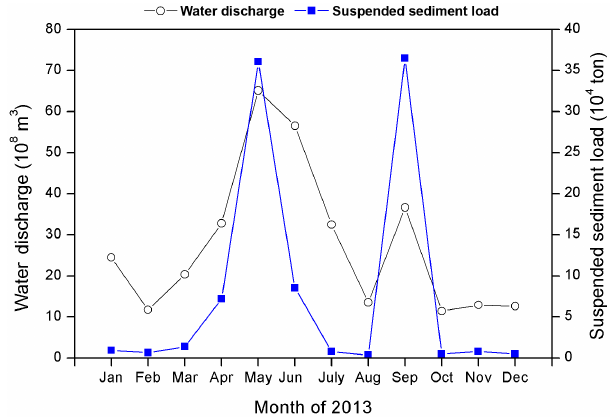
Figure 2. Monthly water discharge and suspended sediment load in 2013 at Wulong Hydrological Station. The data were taken from Changjiang Sediment Bulletin 2013 (website: